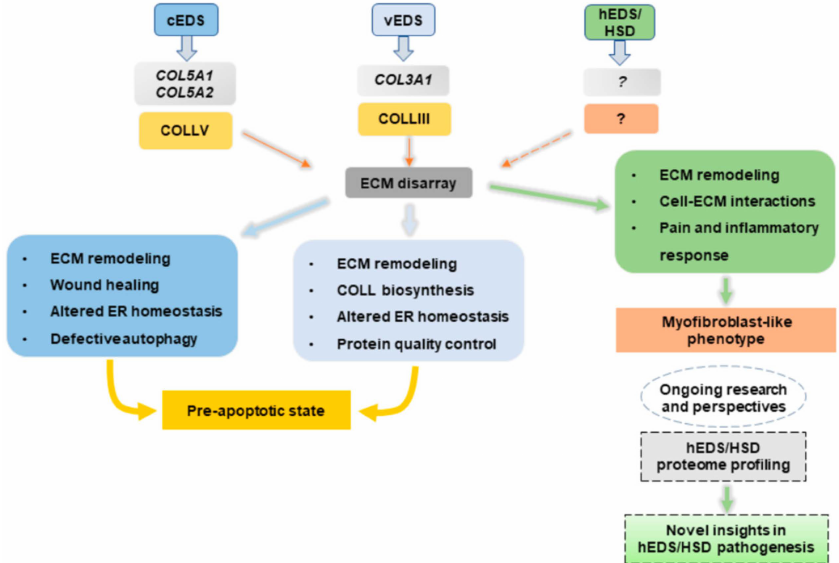
Figure 1. Schematic illustration summarizing the processes likely involved in the pathogenesis of cEDS, vEDS, and hEDS / HSD derived from transcriptome and in vitro studies of patients’ skin